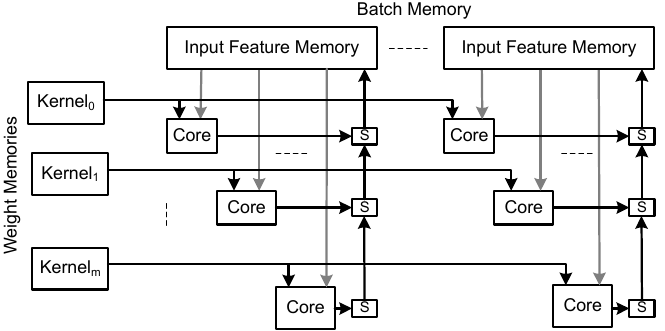
Figure 10. Architecture of the fully connected PE cluster with support for pruned